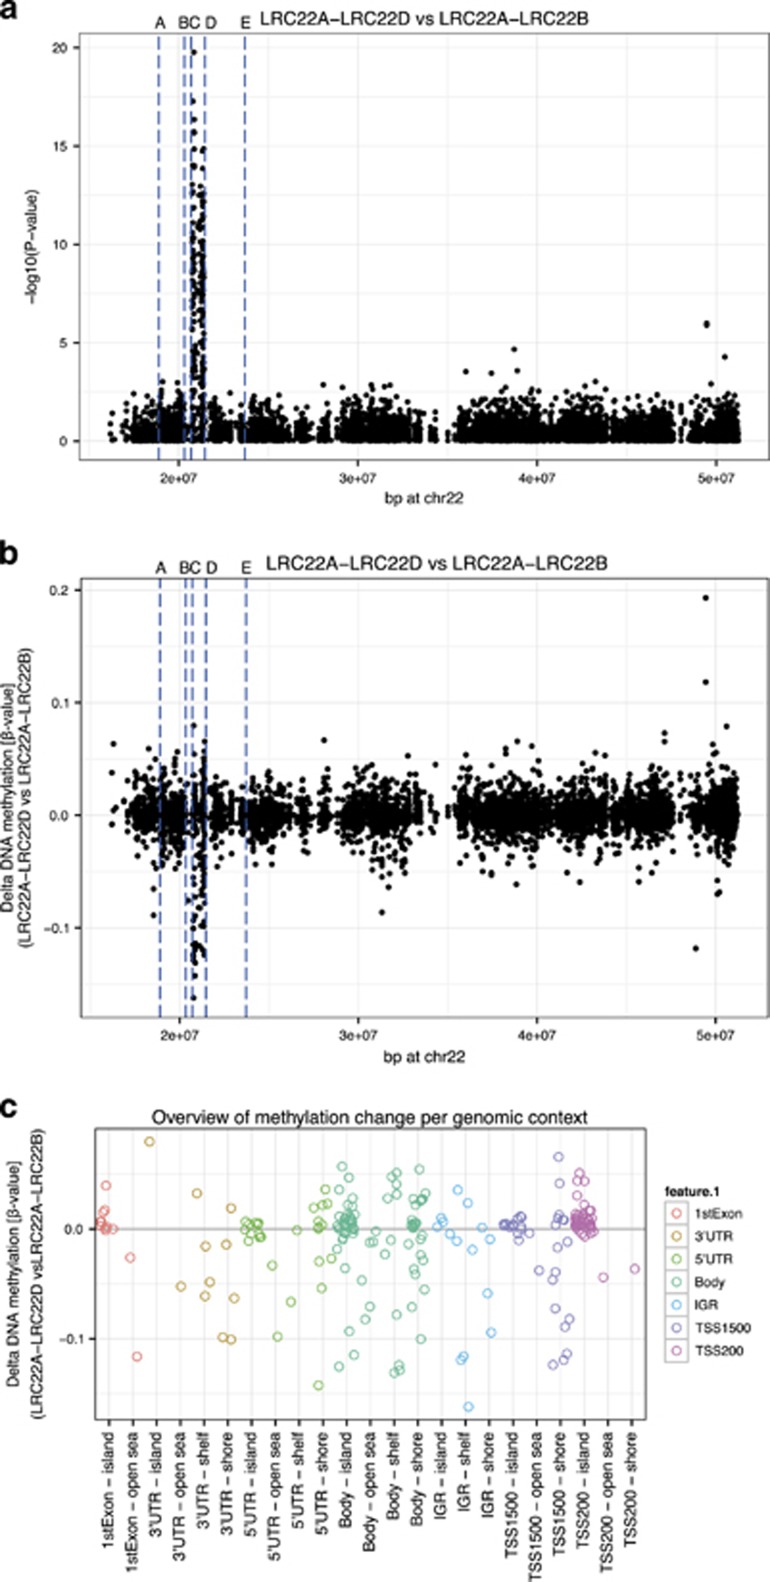
Overview of results located on chromosome 22 from CNV EWAS comparing methylome profiles of 22q11.2 cases with LRC22A–LRC22D versus LRC22A–LRC22B deletion type. Overview of P-values is presented in a, effect sizes in b and genomic and CGI context of findings associated in LRC22C–LRC22D region in c. Horizontal blue lines on a, b indicate boundaries of different 22q11.2 deletion types (lines A–D: LRC22A–LRC22D; A and B: LRC22A–LRC22B; C and D: LRC22C–LRC22D; D and E: LRC22D–LRC22E). CNV, copy number variant; EWAS, Epigenome-Wide Association Study.